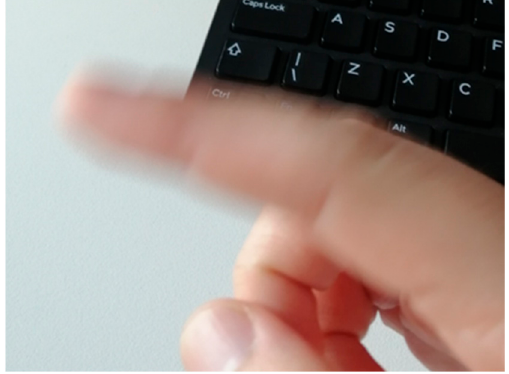
Figure 13. Flicked finger exhibiting motion